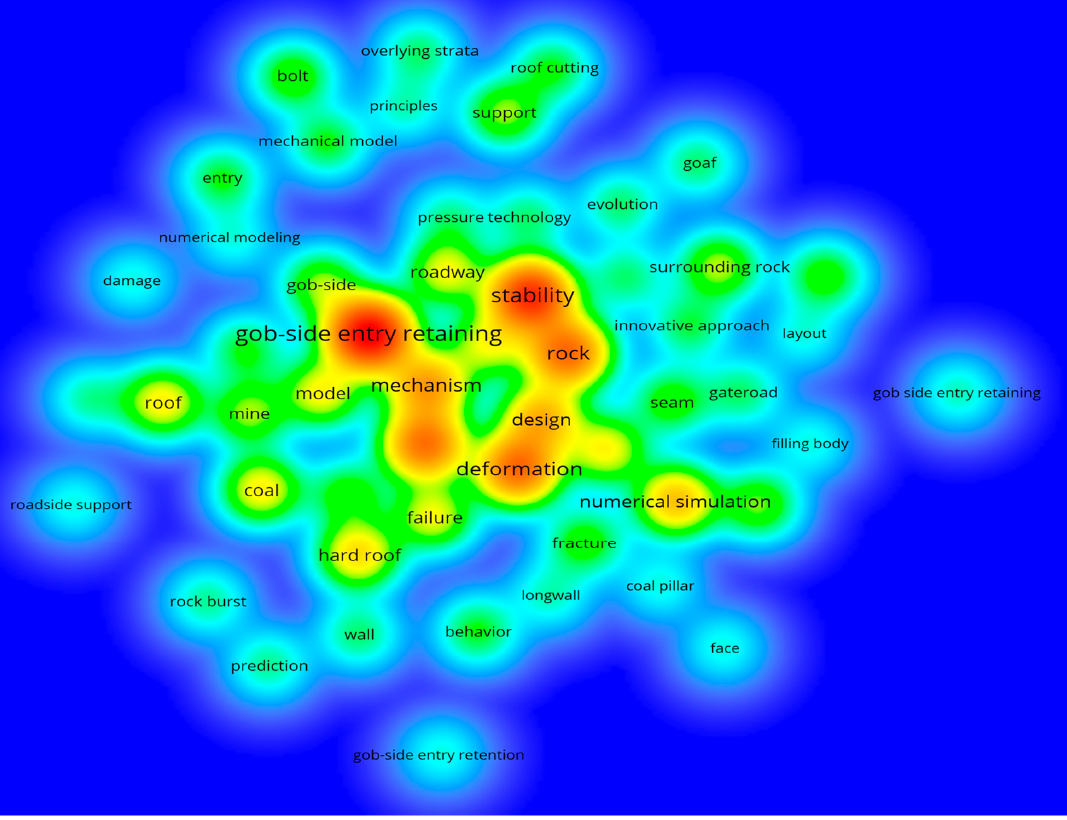
Figure 2. Research hotspot map of gob-side entry driving in fully mechanized caving. It can be seen from Figure 2 that the research hotspots of gob-side entry driving in fully mechanized caving mainly focus on the following five aspects: ① stability of the